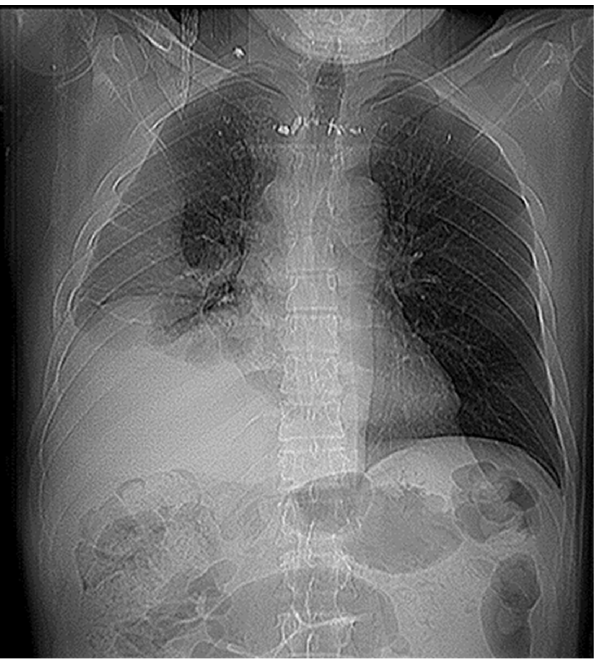
Figure 1. Preoperative CT scan.